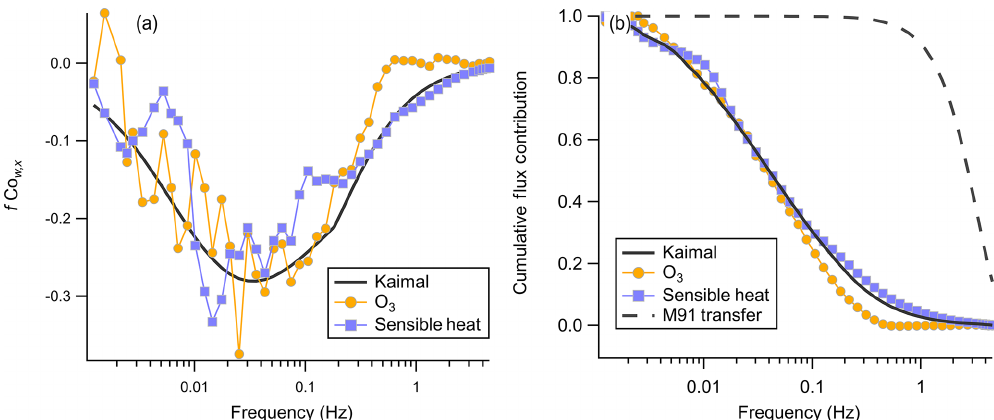
Figure 11. (a) Mean binned frequency-weighted cospectra O 3 and sensible heat flux with vertical wind from the average of two consecutive flux periods from 14:10 to 15:20 local time on 20 July. The Kaimal trace is the idealized cospectra Kaimal et al. (1972) for a mean wind speed of 4.4ms − 1 and an unstable atmosphere. The sensible heat trace is inverted, and the observed net sensible heat flux was positive for this period. (b) Corresponding ogives for cospectra shown in (a) . The M91 transfer trace is the calculated transfer function for turbulent attenuation in a tube from Massman (1991).